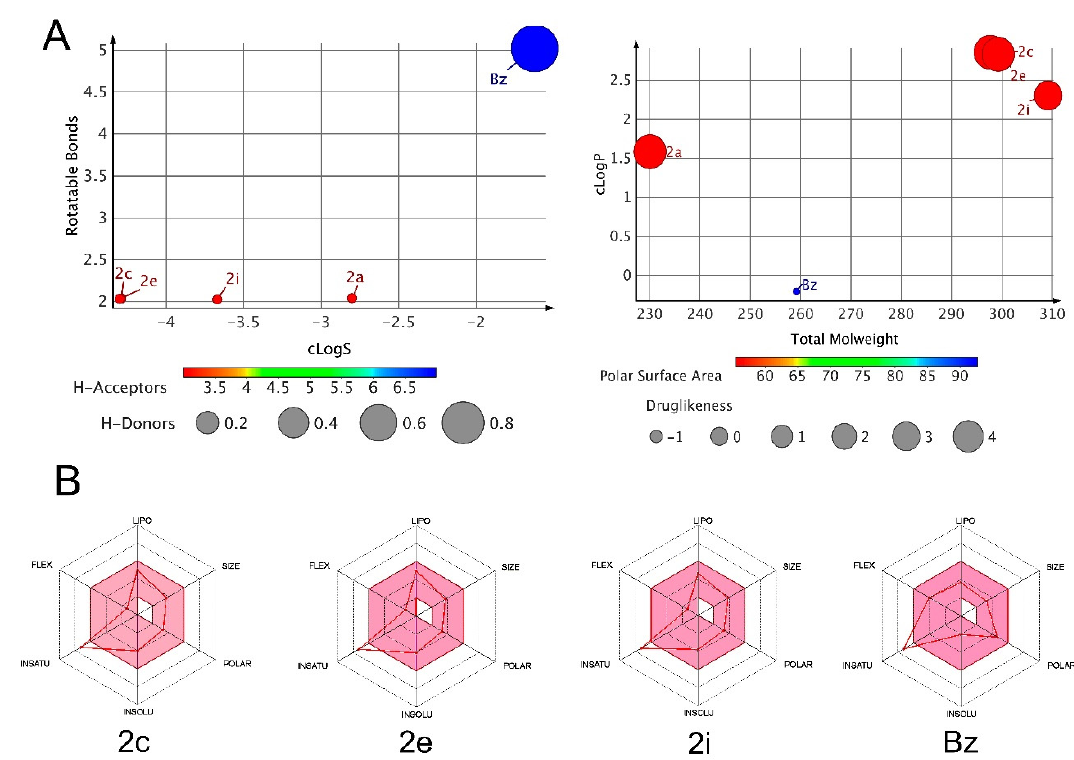
Figure 3. Physicochemical properties of promising pyrazole ‐ thiazoline derivatives ( 2c , 2e , 2i ) and Bz. ( A ) DataWarrior software was used to calculate and plot in 2D graphs the following physicochemical parameters: rotatable bonds, aqueous solubility (cLogS), hydrogen bond donors (HBD) and acceptors (HBA), lipophilicity (cLogP), molecular weight (MW), topological polar surface area (tPSA), and drug-likeness. ( B ) Radar plot representation of six physicochemical parameters (lipophilicity, size, polarity, solubility, flexibility, and saturation), calculated using SwissADME. In red, the threshold values to achieve the drug ‐ likeness criteria.